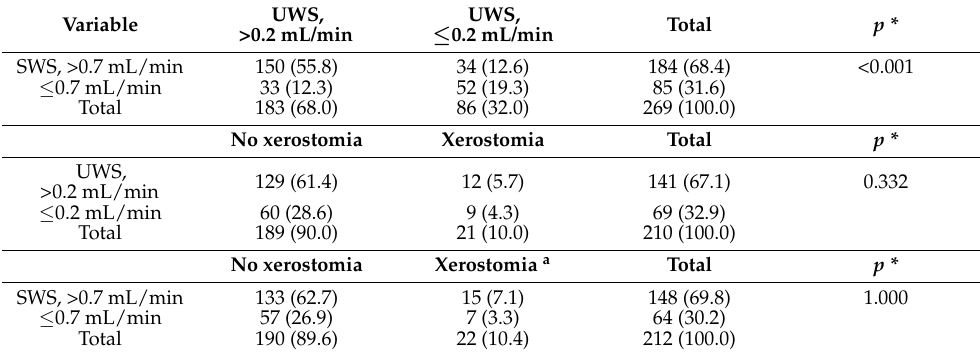
Table 4. Association between objective stimulated and unstimulated salivary flow measurements and xerostomia (data are presented as n (total